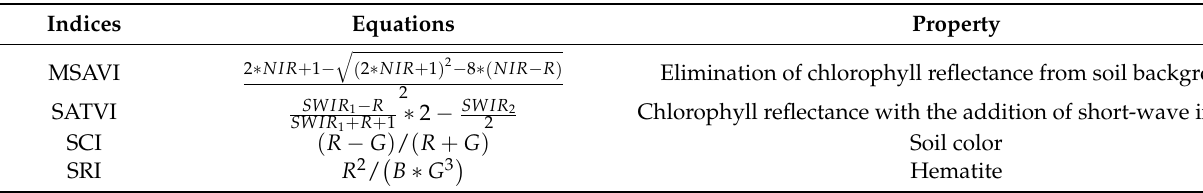
Table 1. Calculation formulas of spectral